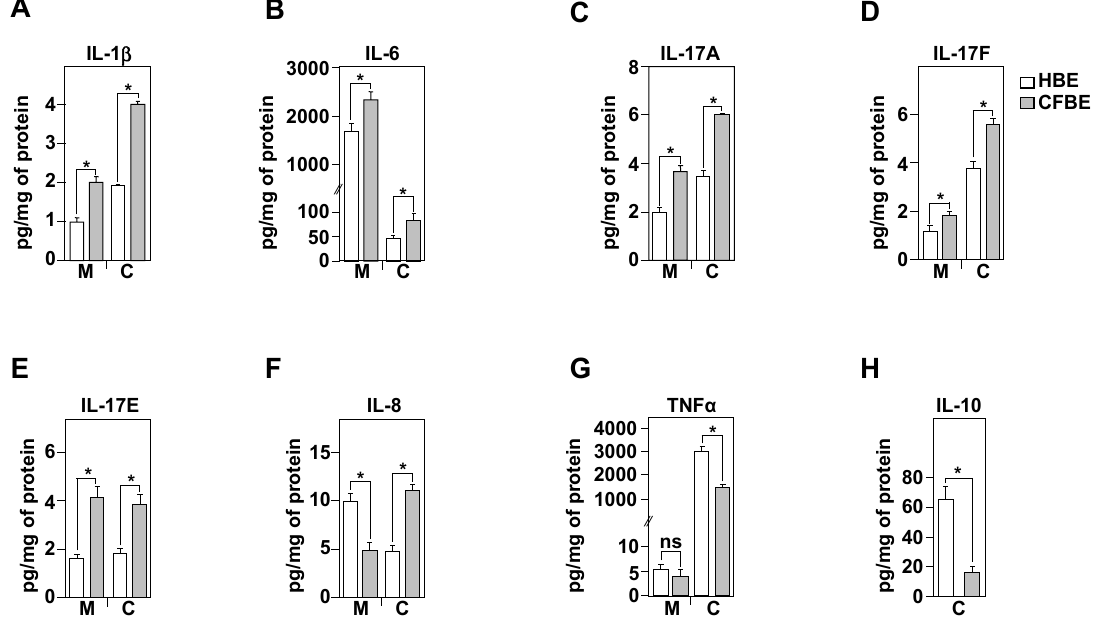
Figure 4. Evaluation of inflammatory profile in healthy and CF bronchial cells. Measurements of IL-1 β ( A ), IL-6 ( B ), IL-17A ( C ), IL-17F ( D ), IL-17 ( E ), IL-8 ( F ), TNF α ( G ), and IL-10 ( H ), released in the culture media (M), or present in protein extracts (C). The cytokines were assayed using a quantitative sandwich enzyme-linked immunoassay (ELISA) in HBE (white charts) and CFBE (black charts). Concentrations are in pg/mg of extracted proteins. Values overwritten with asterisk are different from the control ( p < 0.05). Data are expressed as mean ± SE ( n = 6).